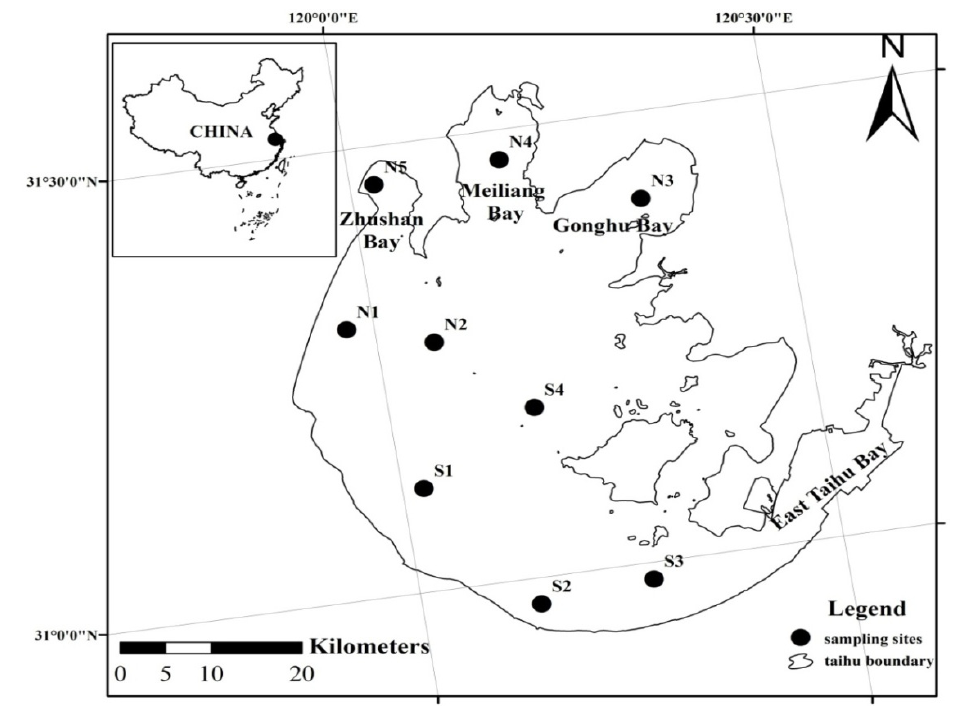
Figure 1. Sampling stations in Lake Taihu (N1–N5,